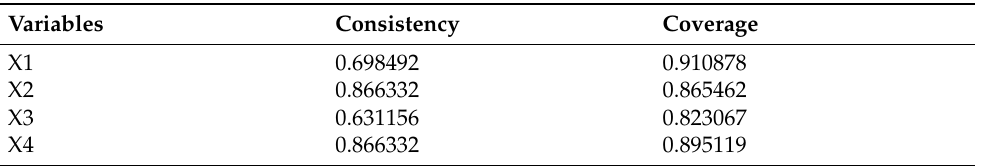
Table 5. Consistency and coverage table of conditional